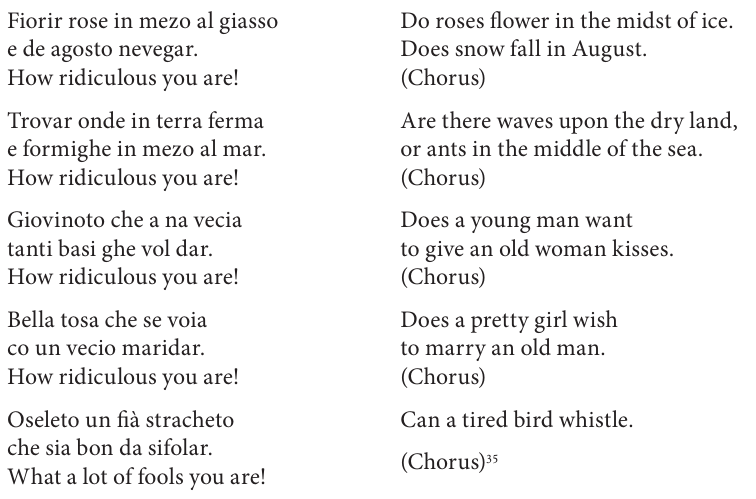
For the composer, the idea of mocking laughter provided an opportunity to exploit a genuinely operatic effect, as for example Carl Maria von Weber in his Freischütz and Verdi in Falstaff had done before. While one might have expected to find the ominous “plague motif” integrated into the musical texture, Britten opts for another, less obvious solution that gives the song a completely different twist. His “Laughing Song” sounds like a dull nursery rhyme accompanied by a dreary change of chords in horns, clarinets, and bassoons imitating a concertina (example 4), while the vocal part is marked “con voce